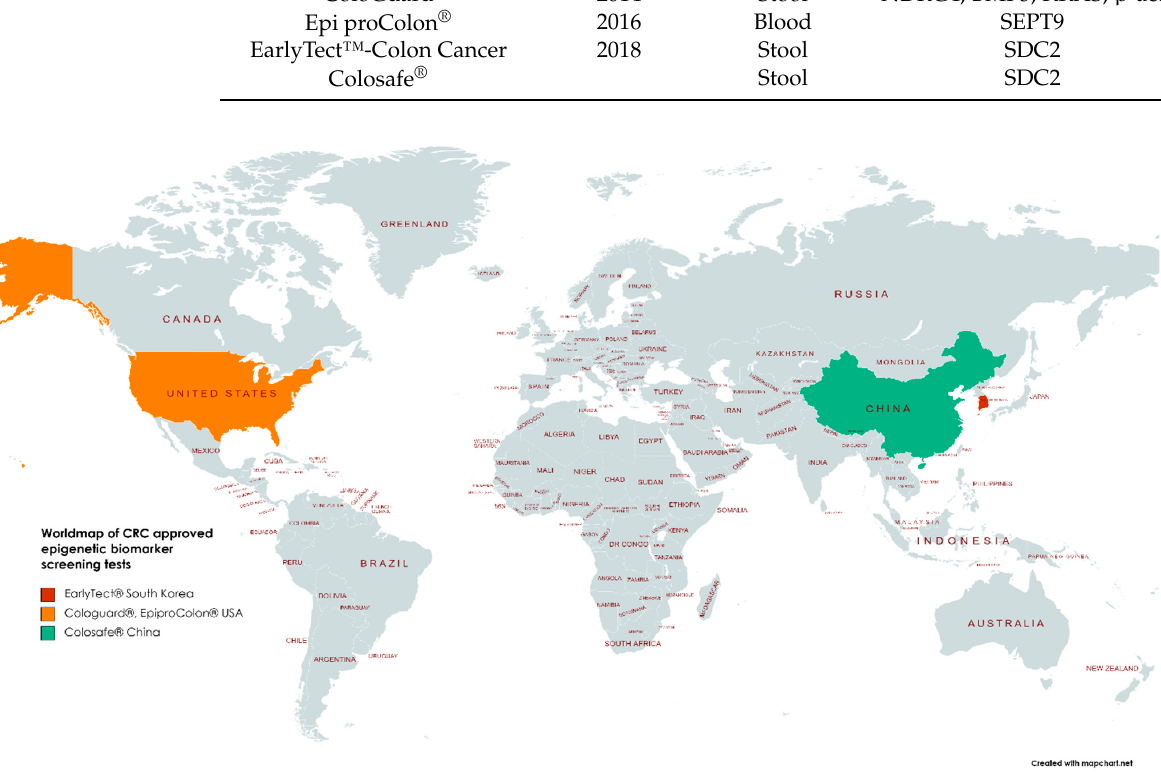
Figure 3. Map of approved epigenetic screening test kits Cologuard ® , Epi proColon ® —USA, Colosafe ® China, EarlyTect ® Korea. Colodefense ® (China, 2021) is used at present only for research objectives.